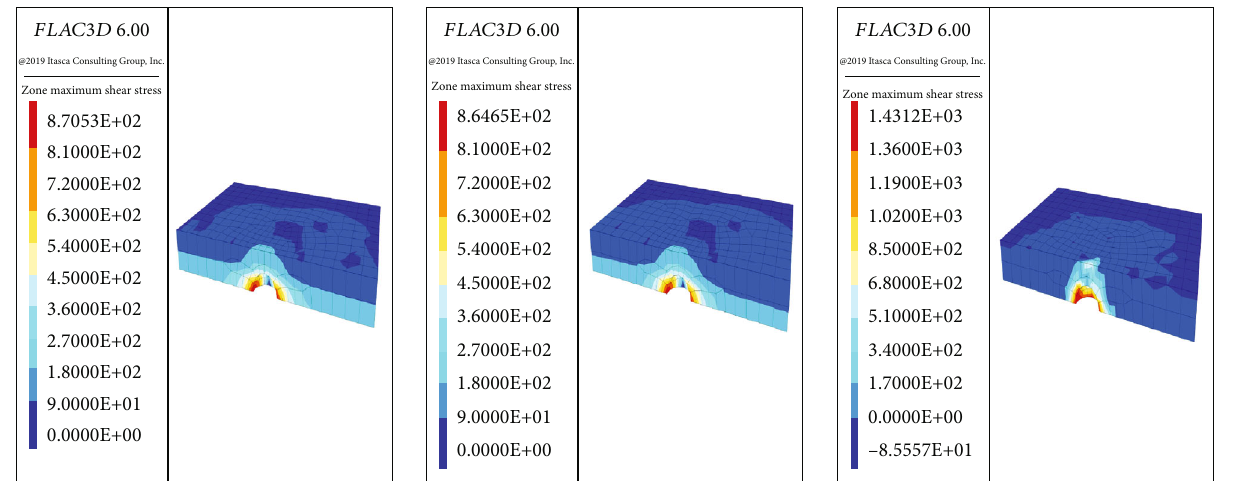
Figure 13: Variation of maximum shear stress during the dropping process with initial water level heights of 0mm, 25mm, and 100mm,